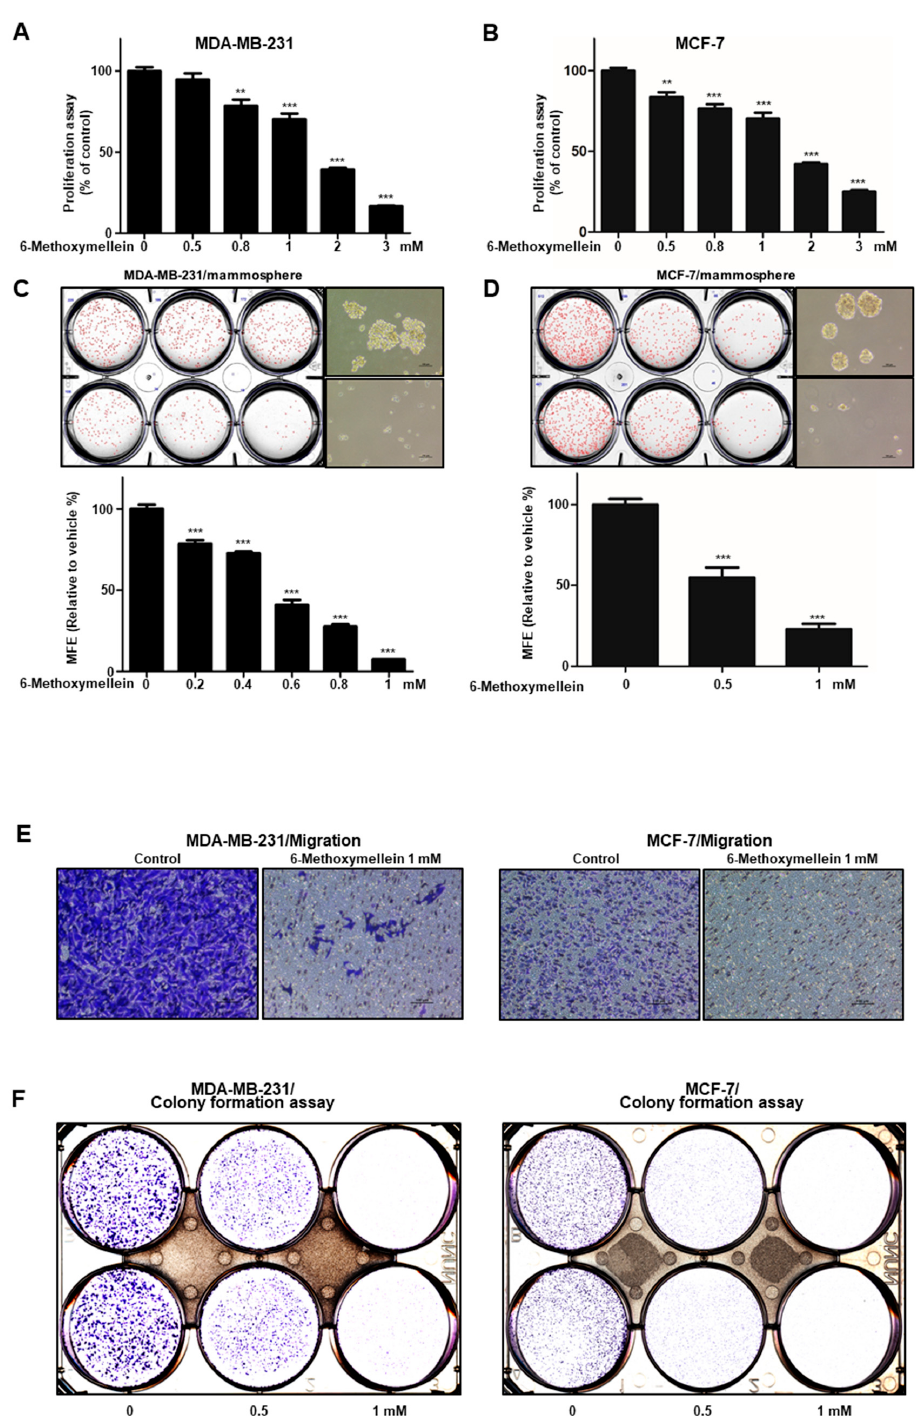
Figure 3. The antiproliferation and mammosphere formation inhibitory e ff ect of 6-methoxymellein. ( A , B ) The antiproliferation ability of 6-methoxymellein was assayed with an EZ-Cytox assay kit using breast cancer cells treated with 6-methoxymellein. ( C , D ) To establish the inhibitory e ff ect of 6-methoxymellein on mammosphere formation, breast cancer cells were cultured in 6-well plates (ultralowattachment)withCSCculturemediacontainingincreasingconcentrationsof6-methoxymellein or DMSO alone after 7 days. The images were captured and are representative mammospheres by microscopy at 10 × magnification (scale bar = 100 µ m). ( E , F ) The migration of MDA-MB-231 and MCF-7 cells was determined by Transwell assay after exposure to 6-methoxymellein (scale bar: 100 µ m). 6-Methoxymellein inhibits the colony formation of MDA-MB-231 and MCF-7 cells. Our representative data were collected. Our data are represented as the mean ± SD; ** p < 0.01; *** p <